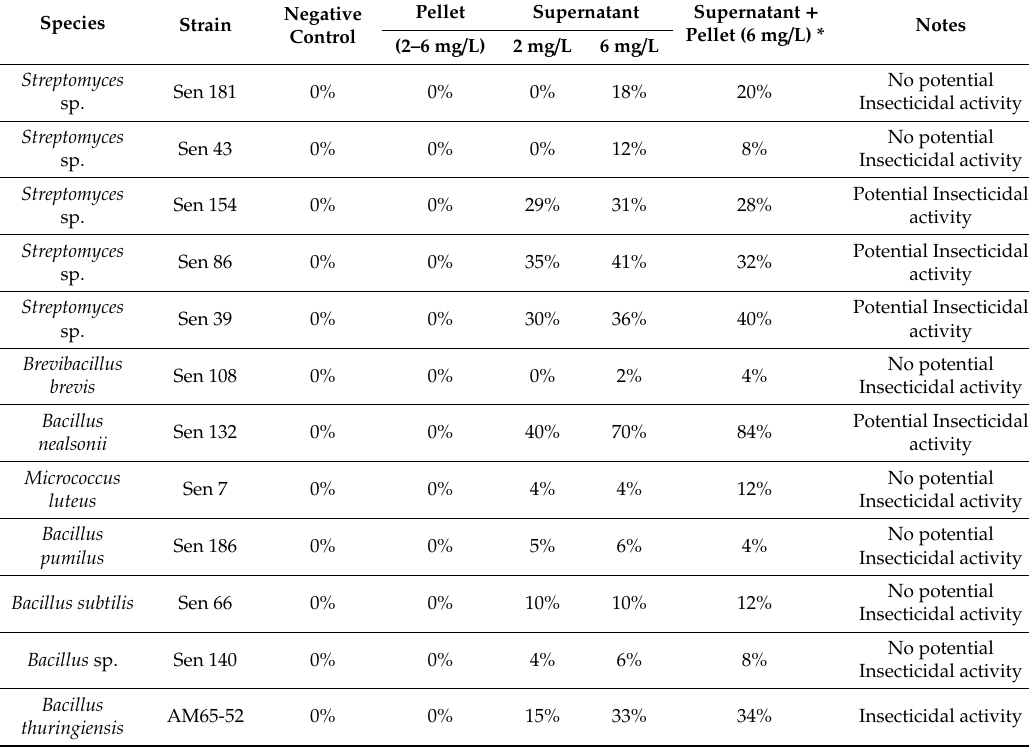
Table 2. Detailed results of the insecticidal activity of the secondary metabolites of the isolated species against third and early fourth instar A. albopictus larvae at 72 h